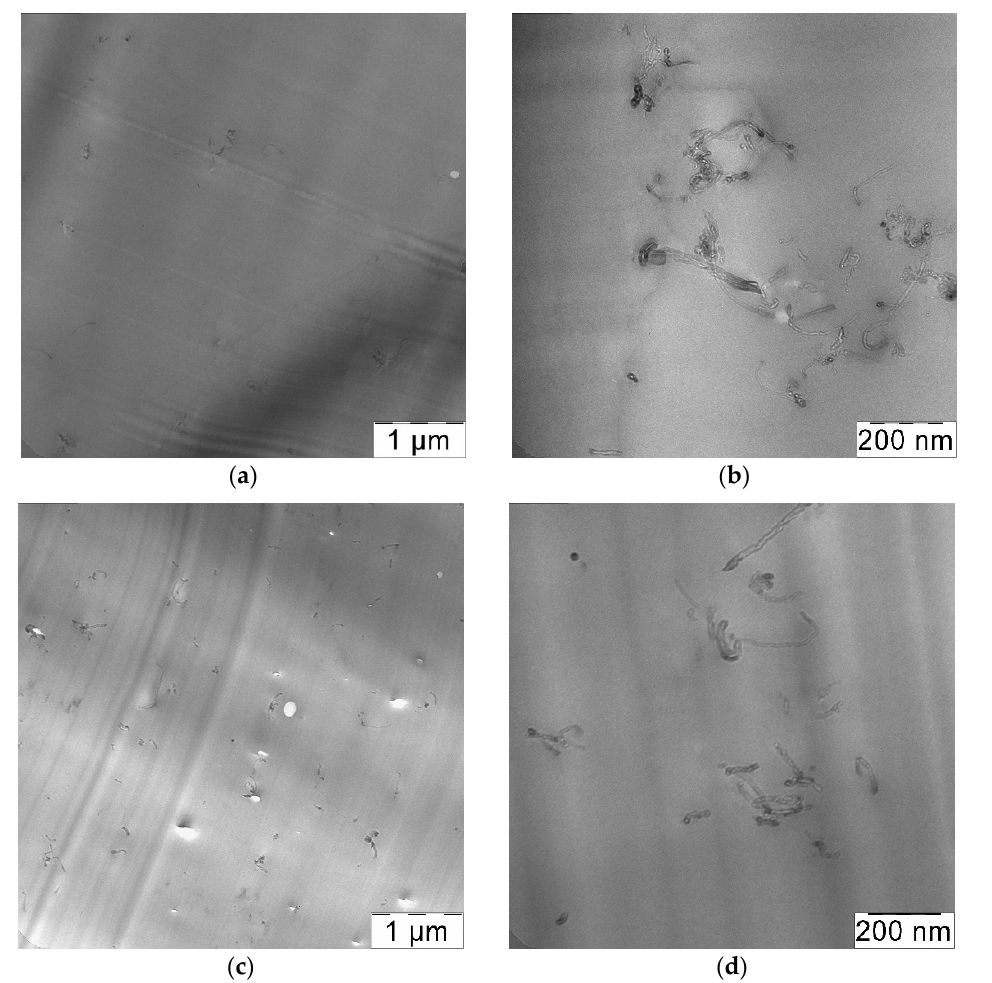
Figure 11. Transmission electron microscopy (TEM) images of composites obtained by SAS with untreated CNTs ( a , b ) (experiment № 1) and CNTs processed by RESS ( c , d ) (experiment № 3).